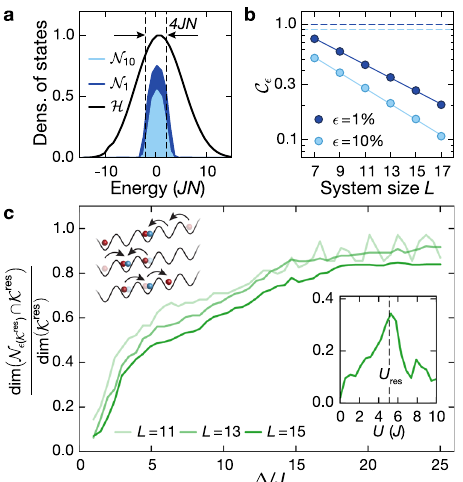
Fig. 4 Theoretical analysis of the relevant many-body states for ω h = 0, Δ = Δ ≡ Δ and a Néel-ordered initial state. a Density of states in the full ↑ ↓ Hilbert space H restricted to quarter fi lling and zero magnetization for the numerical fragments N 1 ( ϵ = 1%), N 10 ( ϵ = 10%), U = 5 J , Δ = 3 J and T τ , normalized to the maximum in H ; L = 15. b Scaling of the N ¼ 1000 fi nite-time connectivity C ϵ with system size for a time window T τ , U = 5 J and Δ = 3 J . Solid lines are exponential fi ts to the data. N ¼ 1000 Dashed lines are the prediction for the fi nite-time connectivity of a thermal state, showing a constant scaling at 1 − ϵ . c Normalized intersection for U = U K res and the numerical fragment res between the Krylov subspace N N K res Þ (main text). The ϵ ð K res Þ (Methods), where dim ð ϵ ð K res Þ Þ ¼ dim ð schematic shows the most important processes, connecting the states within the Krylov subspace K res (Supplementary Note 4). Inset: Normalized intersection as in the main plot for Δ = 3 J . The dashed line illustrates the resonance condition in regime ①